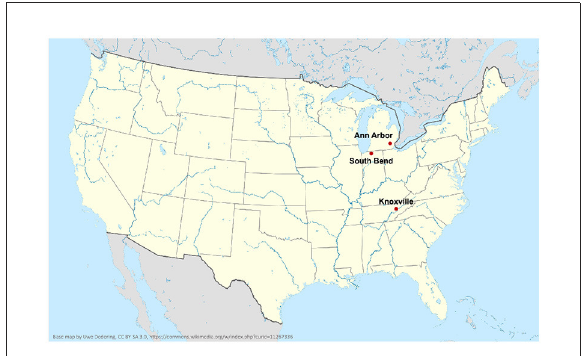
FIGURE1 Three US cities were sample areas for this study.